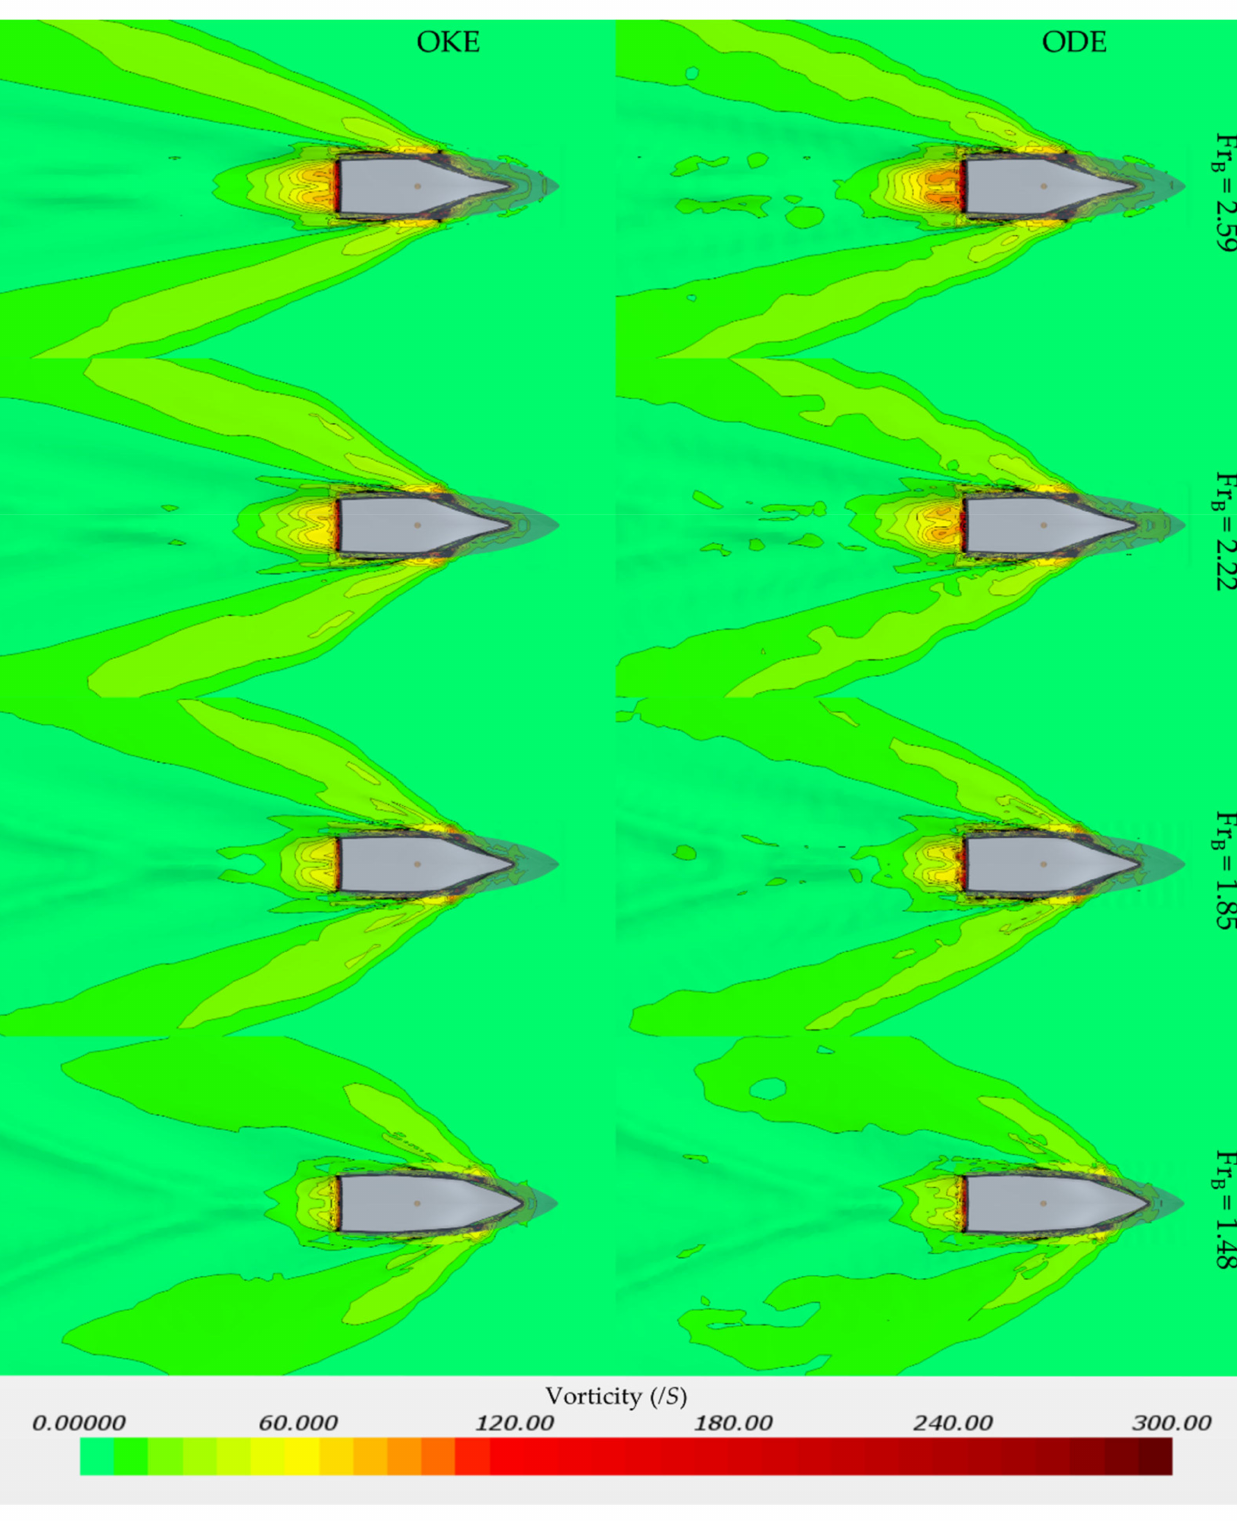
Figure 16. A top view of vorticity contours around the modeled planing vessel at different speeds. The results correspond to CFD simulations performed by employing the overset mesh technique. The left panels show the data corresponding to k- ε model, and the right panels show the data corresponding to DES